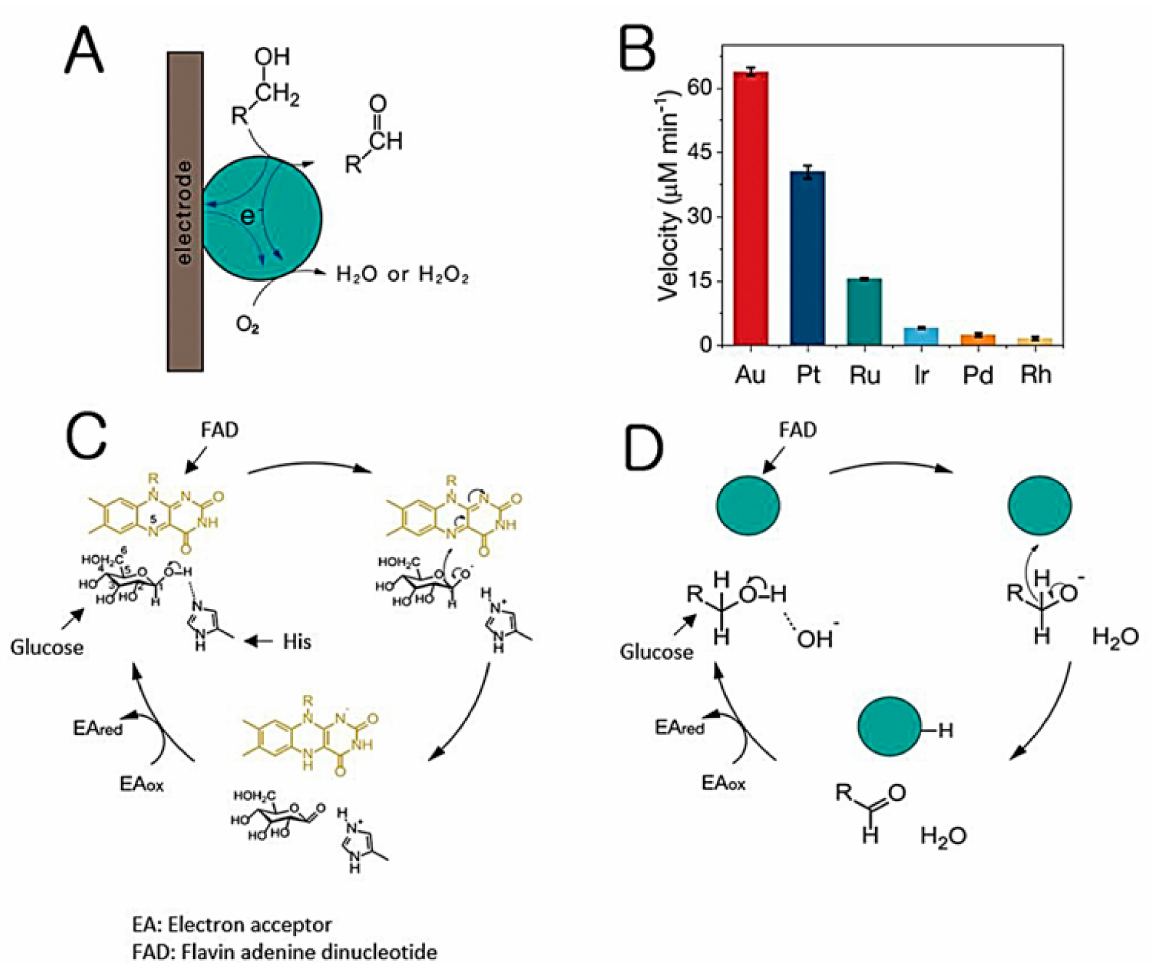
Figure 2. ( A ) Schematic illustration of electron transfer in the electrocatalytic oxidation of alcohols and the oxygen reduction reaction. ( B ) Comparison of the reaction rates. ( C ) Mechanism of glucose oxidation catalyzed by natural glucose oxidase (GOx). ( D ) Mechanism of glucose oxidation catalyzed by noble metal nanozyme. Reprinted with permission from ref. [35]. Copyright 2021 Springer